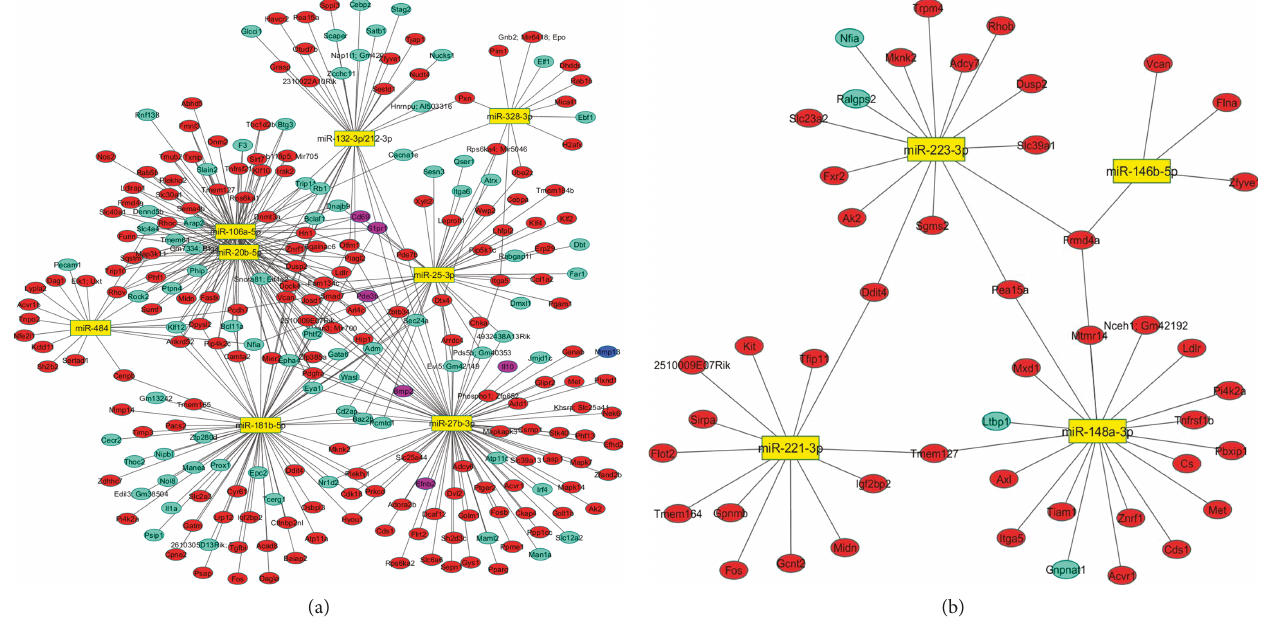
Figure 5: mRNA-miRNA interaction network. (a) miRNAs upregulated in AIRmax mice and their interaction with predicted target genes; (b) miRNAs upregulated in AIRmin mice and their interaction with predicted target genes. Red and blue=upregulated genes; green and purple =downregulated genes. The interaction network was built with Cytoscape